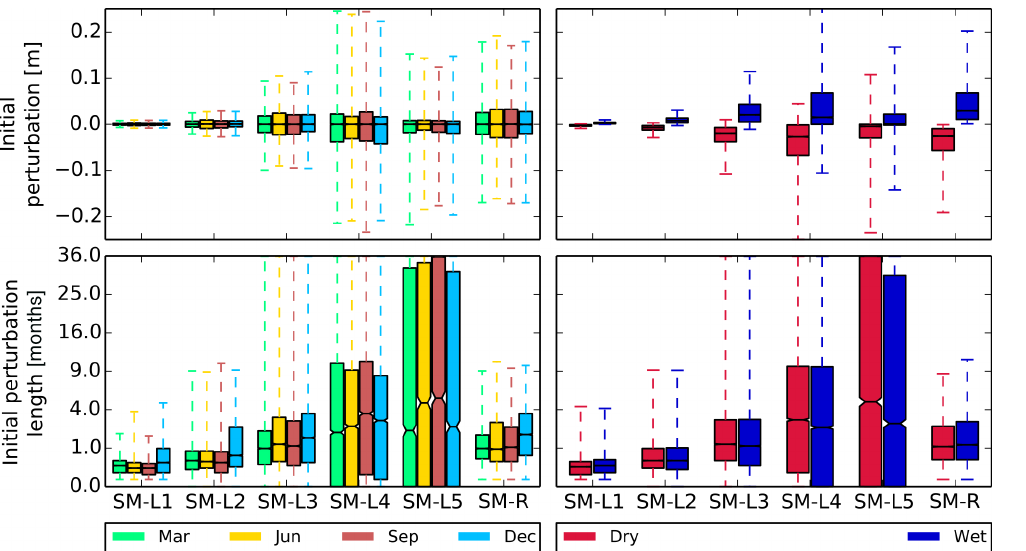
Figure 3. Initial perturbation (cid:49)θ 0 (upper panels) and perturbation length τ 0 (lower panels) statistics subdivided into seasonal ensembles (left) as well as into wet and dry initialized ensembles (right). Metrics are shown for soil layer moisture (SM-L1–5]) and the root zone soil moisture (SM-R) for all land surface grid cells. The whiskers indicate the 1st and 99th percentiles, the box indicates the interquartile range, and the notch indicates the median. Note the quadratic axis for τ 0